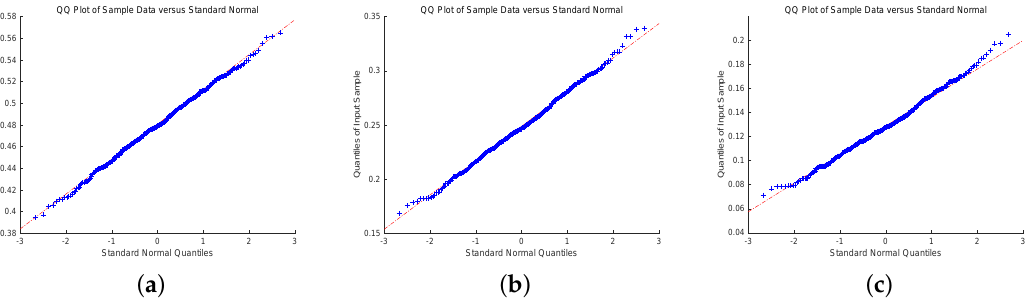
Figure 2. QQ-plot of RP for Exponential claim size density with T = 1440: ( a ) u = 1; ( b ) u = 3; ( c ) u = 5.